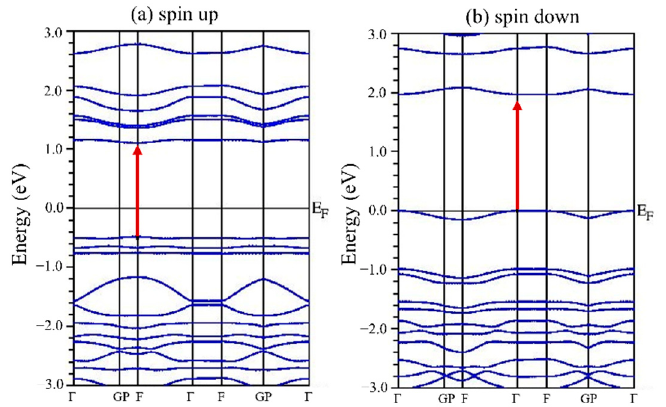
Figure 12. ( a ) Spin up, and ( b ) spin down channel of the band structure of BiFeO 3 thin film.